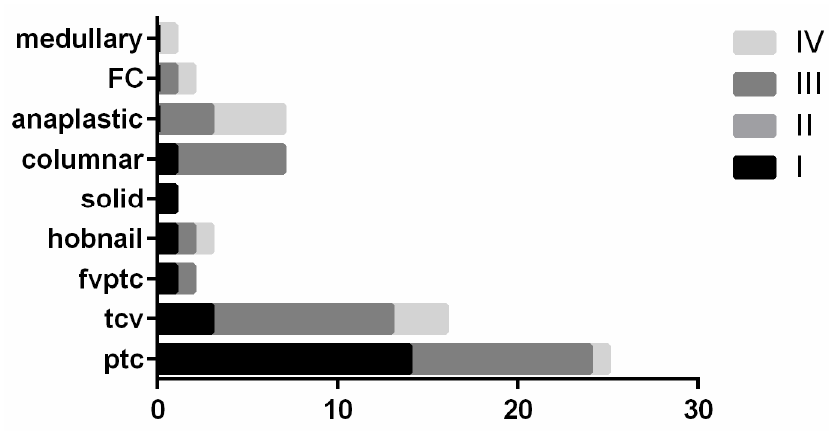
Figure 2. Distribution of thyroid cancer histotypes and stages of thyroid carcinomas.